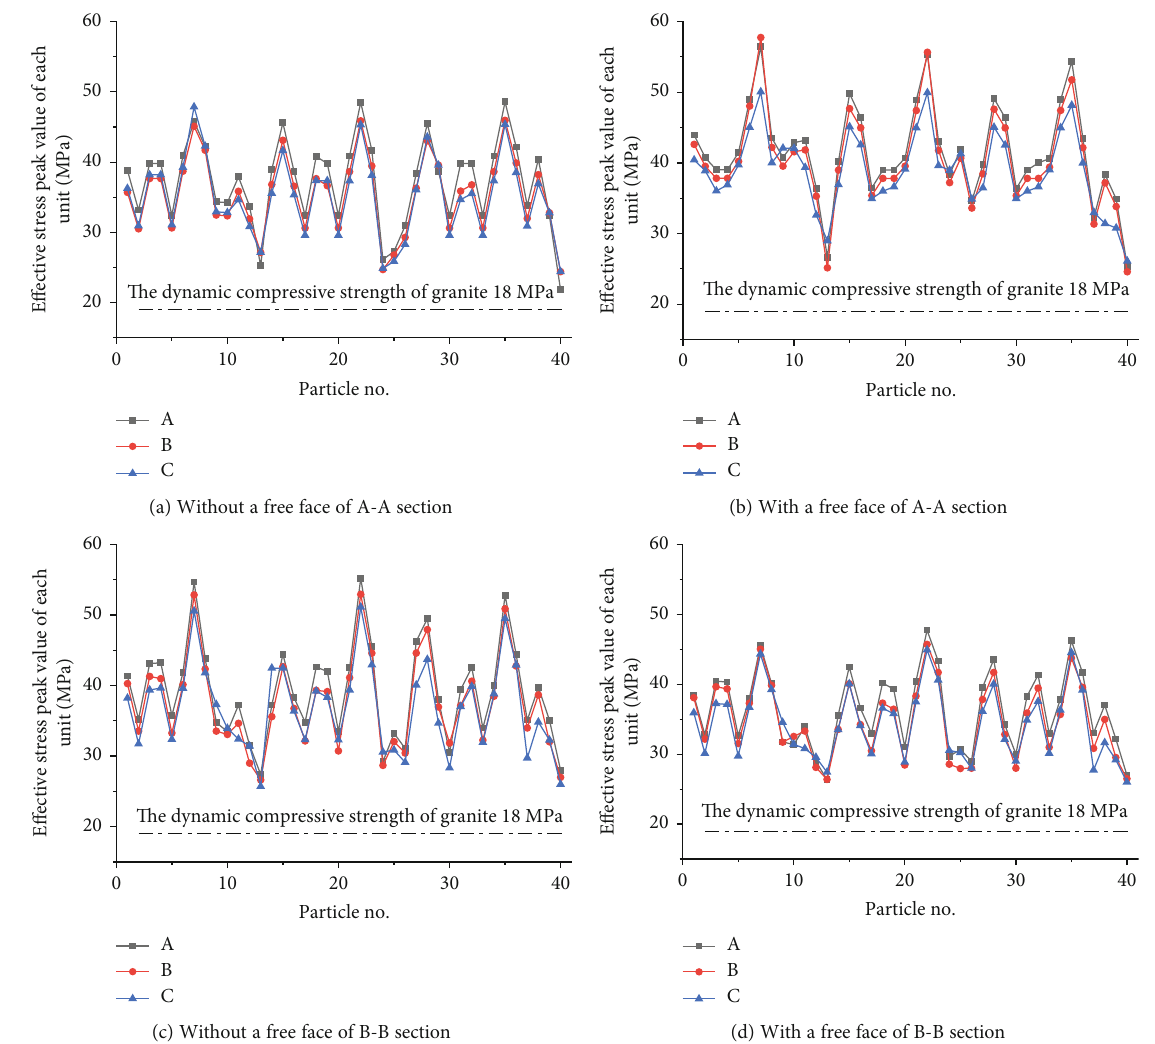
Figure 22: Peak e ff ective stress values of the